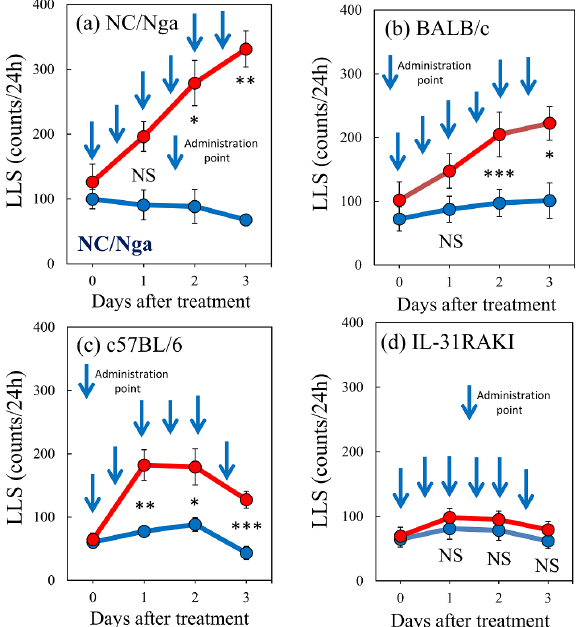
Figure 7. Effect of repeated administration of IL-31 on long-lasting scratching (LLS) counts between NC/Nga, BALB/c, C57BL/6, and IL-31RAKI mice. Effect of repeated administration of IL-31 on the LLS counts of ( a ) SPF-NC/Nga mice. ( b ) BALB/c, ( c ) C57BL/6, and ( d ) IL-31RAKI (IL-31RA-deficient) mice. Blue arrows indicate the vehicle (phosphate-buffered saline (PBS), 10 mL/kg, subcutaneous, every 12 h for 3 days) or IL-31 (50 μg/kg, s.c., every 12 h for 3 days) administration points. Blue lines indicate vehicle-administered mice, and red lines indicate IL-31-administered mice. Each value represents the mean ± standard error (S.E.) from six mice (total of 48 mice). NS. not significant. * p < 0.05, ** p < 0.01, and *** p < 0.001 when compared with the respective value of vehicle-treated mice (Student’s t -test with Bonferroni collection).